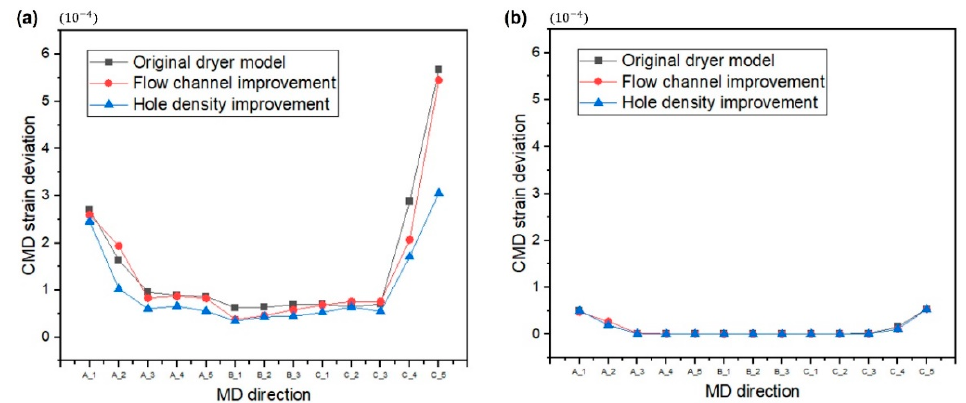
Figure 17. Strain distributions of the ( a ) PET and ( b ) PI films.